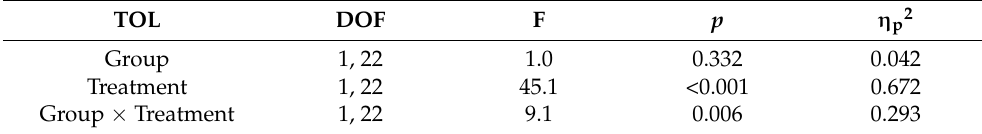
Table 3. ANOVA data of the WISC-IV cancellation. Degrees of freedom (DOF). TOL DOF